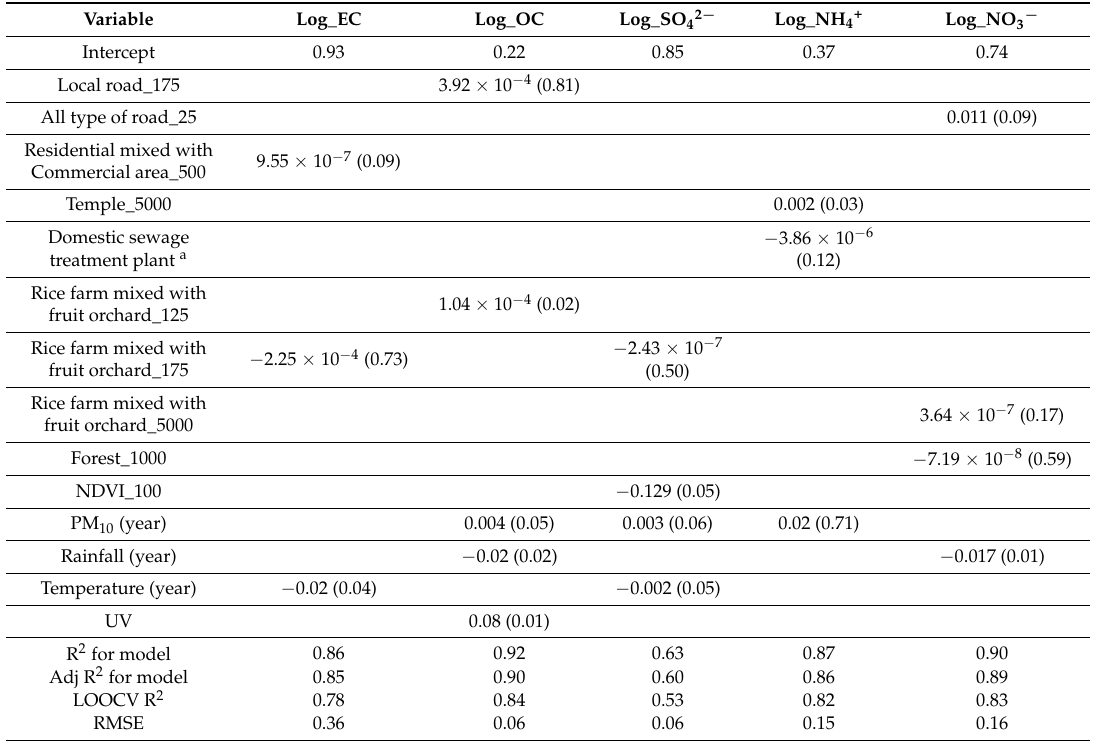
Table 2. Results of land-use regression (LUR) models for regression coefficient (partial R 2 ) for non-metal PM 2.5 -bound